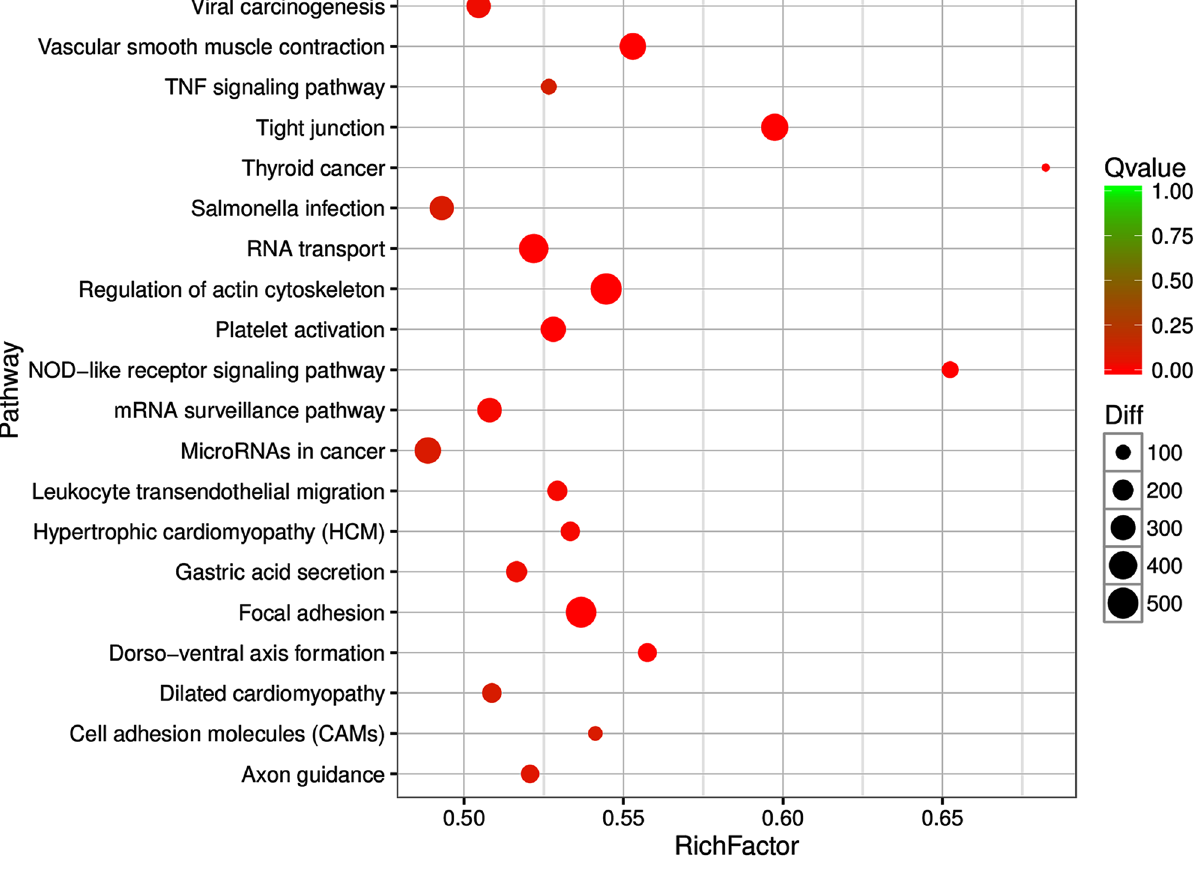
Fig 5. KEGG analysis for the target genes of six